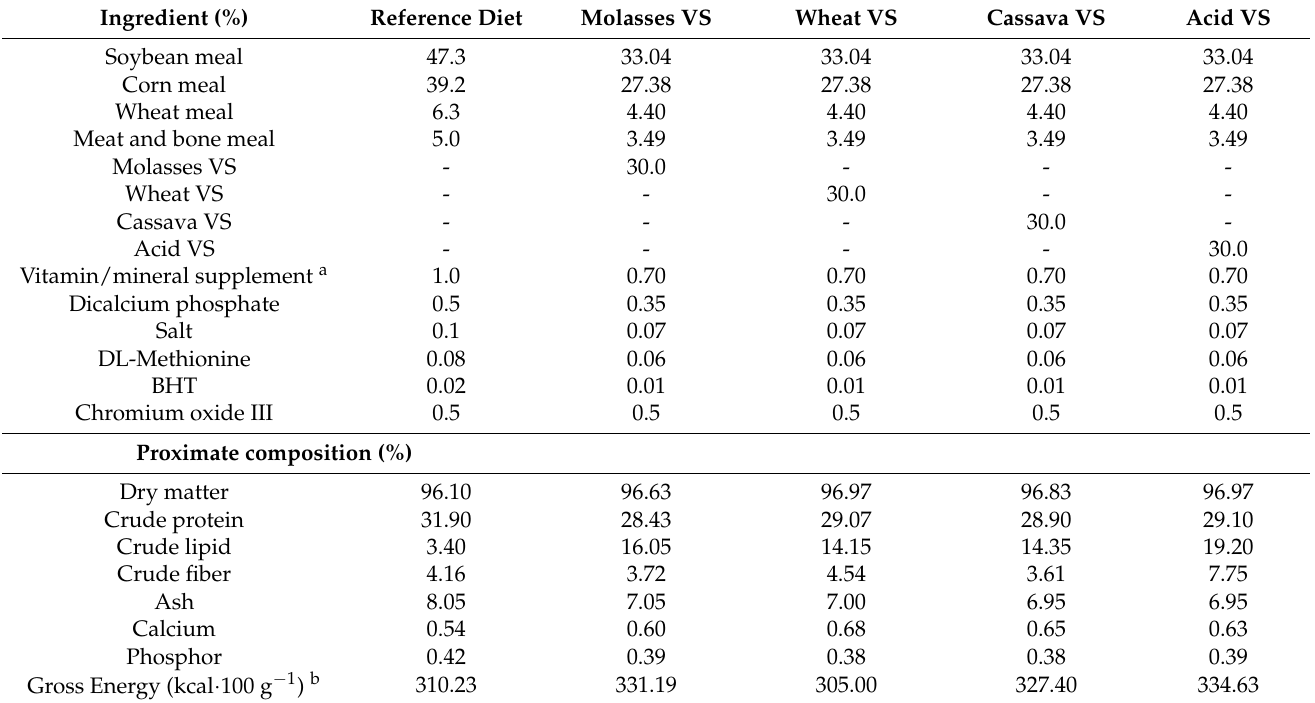
Table 1. Formulation and proximate composition of the reference diet of the in vivo digestibility